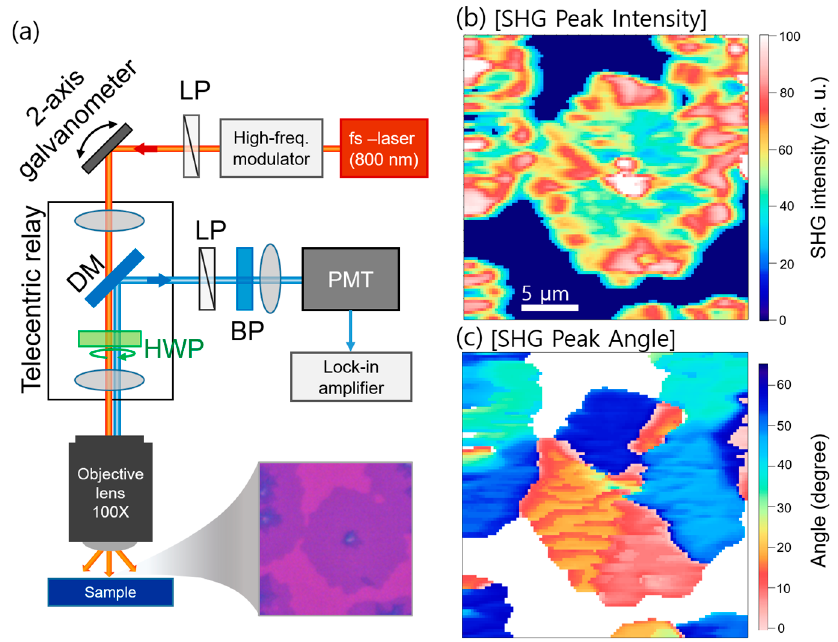
Figure 1. ( a ) Schematic of the SHG measurements (LP: linear polarizer, DM: dichroic mirror, HWP: zero-order half-wave plate, BP: band-pass filter, PMT: photomultiplier tube); ( b ) SHG peak intensity mapping of the WSe 2 flakes shown in the inset of ( a ), which is extracted from the angle-dependent 2D SHG images; ( c ) Mapping of the SHG peak angle for identifying different crystal orientations within the flakes.